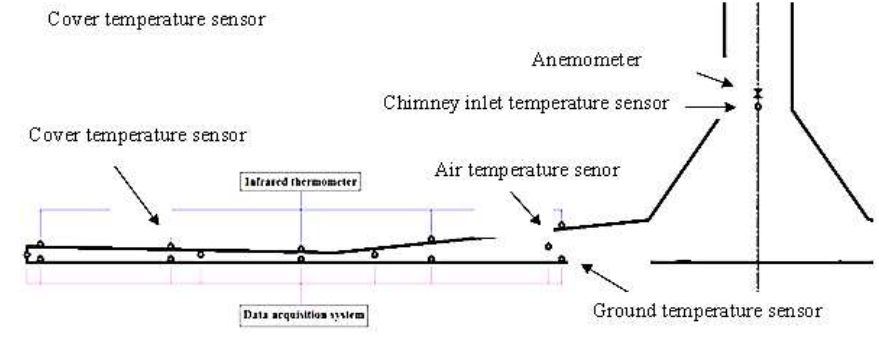
Fig. 9. Layout of thermocouples and data collecting